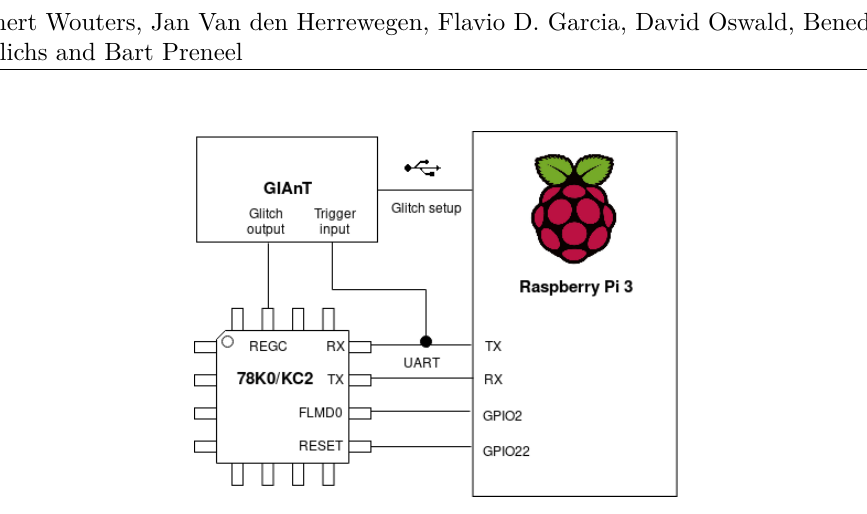
Figure 3: Our setup for the voltage glitching